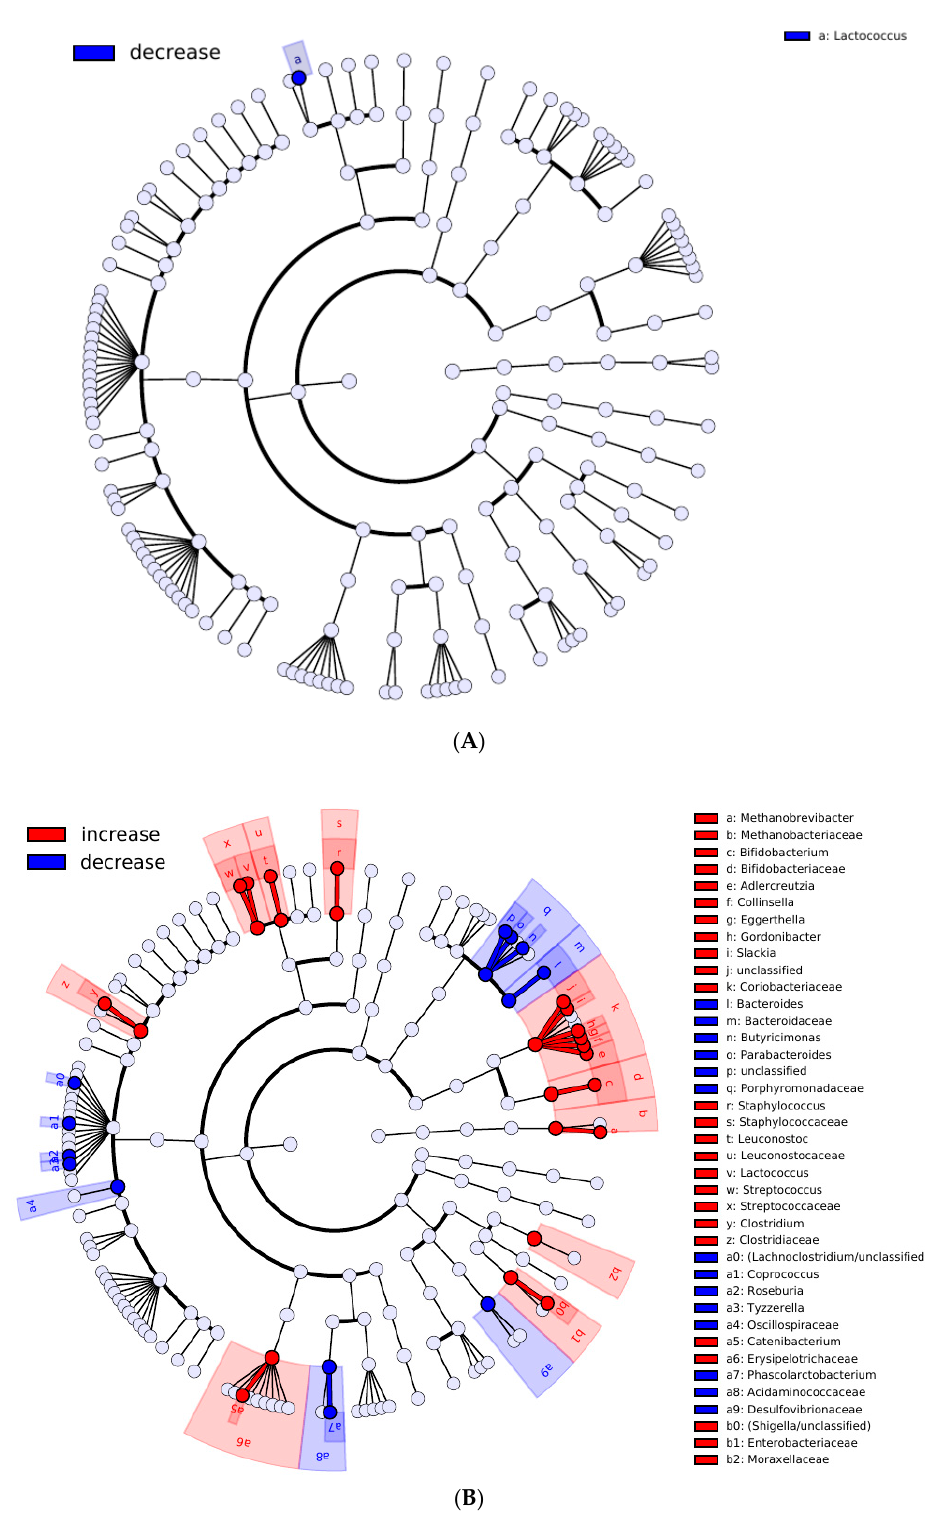
Figure 2. Microbial taxa down to genera level, relative abundance of which significantly changed after the course of FDP consumption, stratified by two clusters. ( A ) Cluster #1 (non-responders); and ( B ) cluster #2 (responders). The hierarchical visualization is performed using GraPhLan: The increased taxa are shown in blue, the decreased in